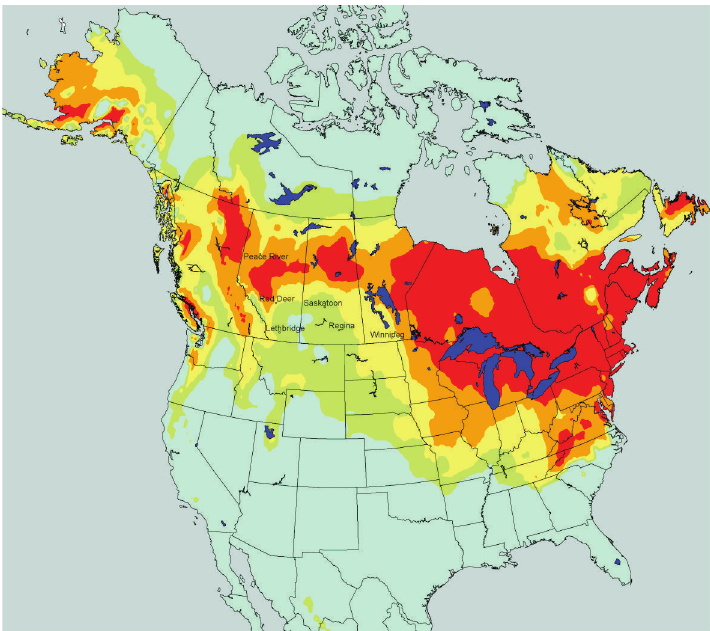
Figure 5: Potential distribution and relative abundance of Sitona lineatus in North America for 2080 as predicted by CLIMEX and the MIROC-H climate change projection. Dark blue: lakes; Light blue = “Unfavourable” (EI = 0–5); Green: “Marginal” (EI = 5–10); Yellow: “Suitable” (EI = 10–15); Tan: “Favourable” (EI = 15–20); Red: “Very Favourable” (EI >